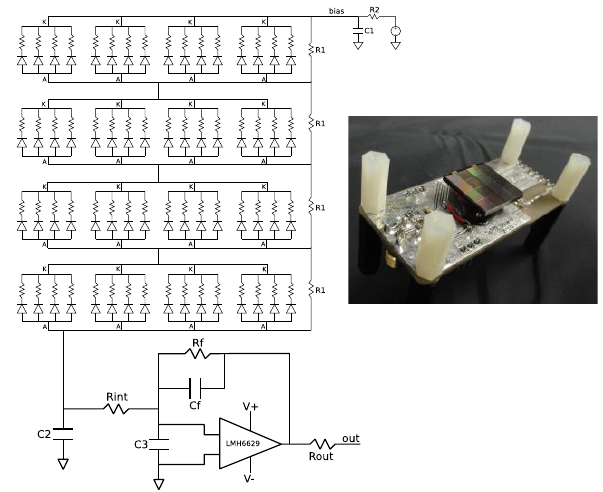
Fig. 2. Scheme (left) and photo (right) of the transimpedance preamplifier used to read-out the anode signals coming from the SiPM